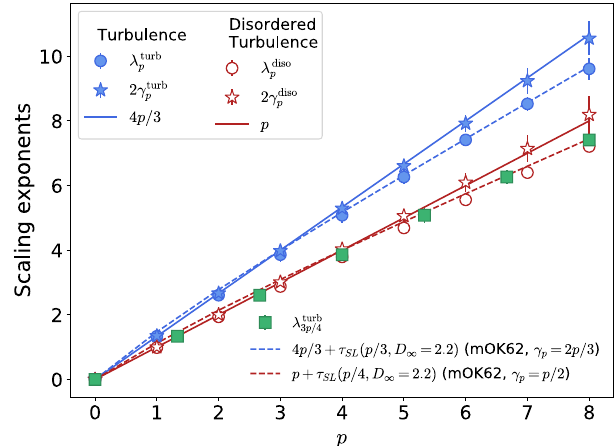
Fig. 4 Velocity circulation scaling exponents. Exponents of the turbulent (in blue) and the disordered turbulence (in red) cases. For each case, the scaling exponents are de fi ned as hj Γ j p i A (cid:3) r λ p (circles) and hj Γ j p i n (cid:3) n γ p (stars). Error bars indicate 95% con fi dence intervals. Self-similar predictions for each case are shown as solid lines. Green squares show the relation between the turbulent and disordered systems given by Eq. (5). The blue and red dashed lines show the OK62 prediction combined with the She – Lévêque model (8) with D ∞ = 2.2 (termed “ mOK62 ” ) for turbulence and disordered turbulence, respectively. Source data are provided as a Source Data fi